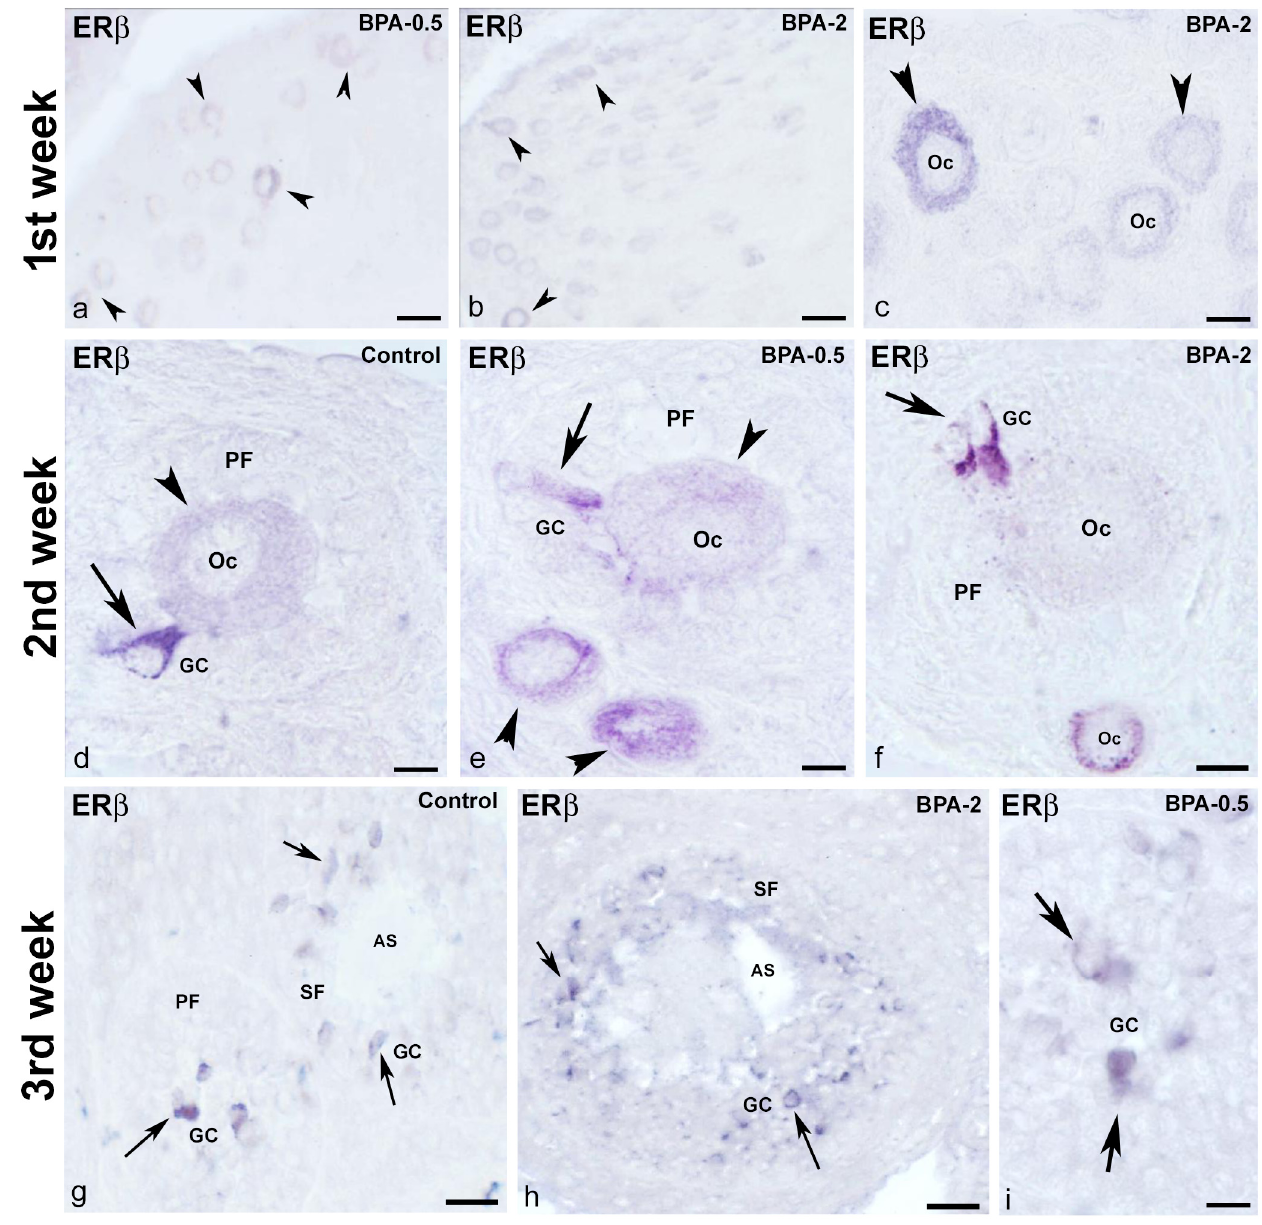
Figure 12. ER β immunoreactivity in offspring ovaries. Representative images of the ovary in the three experimental groups in the three first weeks of postnatal life showing the presence of ER β -ir in oocytes (arrowheads) from primordial follicles in the first week ( a – c ), in oocytes (arrowheads) from primordial and primary follicles as well as in granulosa cells (arrows) from primary follicles in the second week ( d – f ) and granulosa cells (arrows) from primary and secondary follicles in the third week ( g – i ). AS: antral space; GC: granulosa cells; Oc: oocyte; PF: primary follicle; SF: secondary follicle. Scale bars: ( a , b ): 40 µm; ( c , f ): 20 µm; ( d , e , i ): 10 µm; ( g ): 45 µm; ( h ): 36 µm. In dams after weaning, the distribution was the same for both estrogen receptor types, α and β , in all three groups (control, BPA-0.5, and BPA-2), with immunoreactivity in oocytes and granulosa cells (Figure 13a–d).